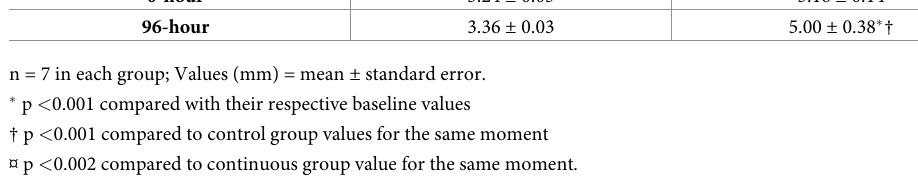
Table 2. Right ventricular wall thicknesses in the control, continuous, and intermittent groups, measured by echocardiography. Time